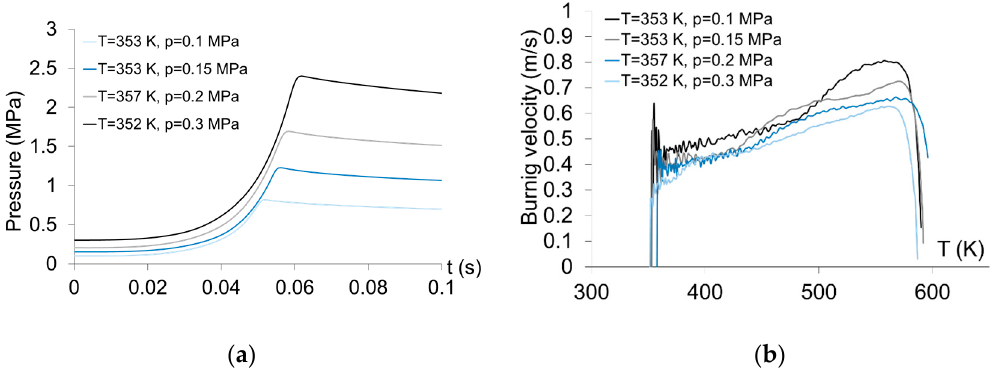
Figure 4. ( a ) Pressure; ( b ) burning velocity. The temporal evolution of the pressure and burning velocity of iso-octane versus the unburned temperature for stoichiometric mixtures with varying initial pressures.